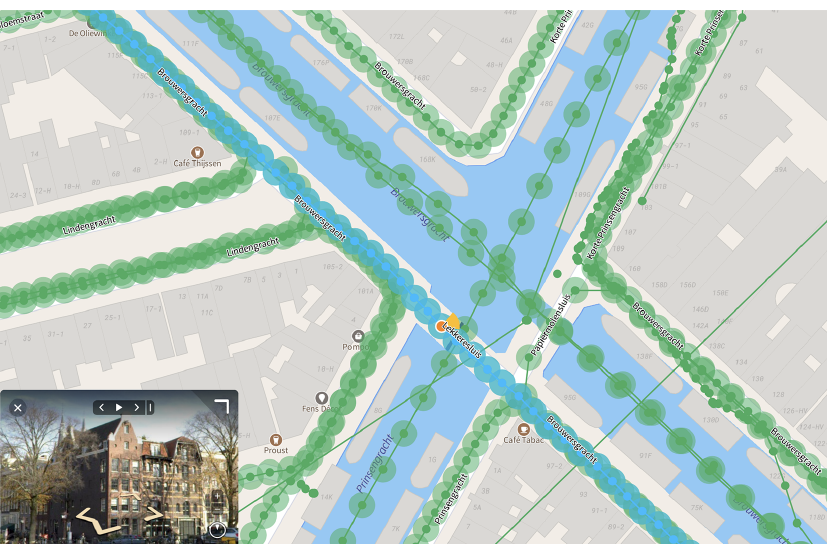
Figure 3. Amsterdam, Brouwersgracht 160 on Mapillary. The green dots in the map indicate the positions of 360° images. Source: Mapillary (2016).